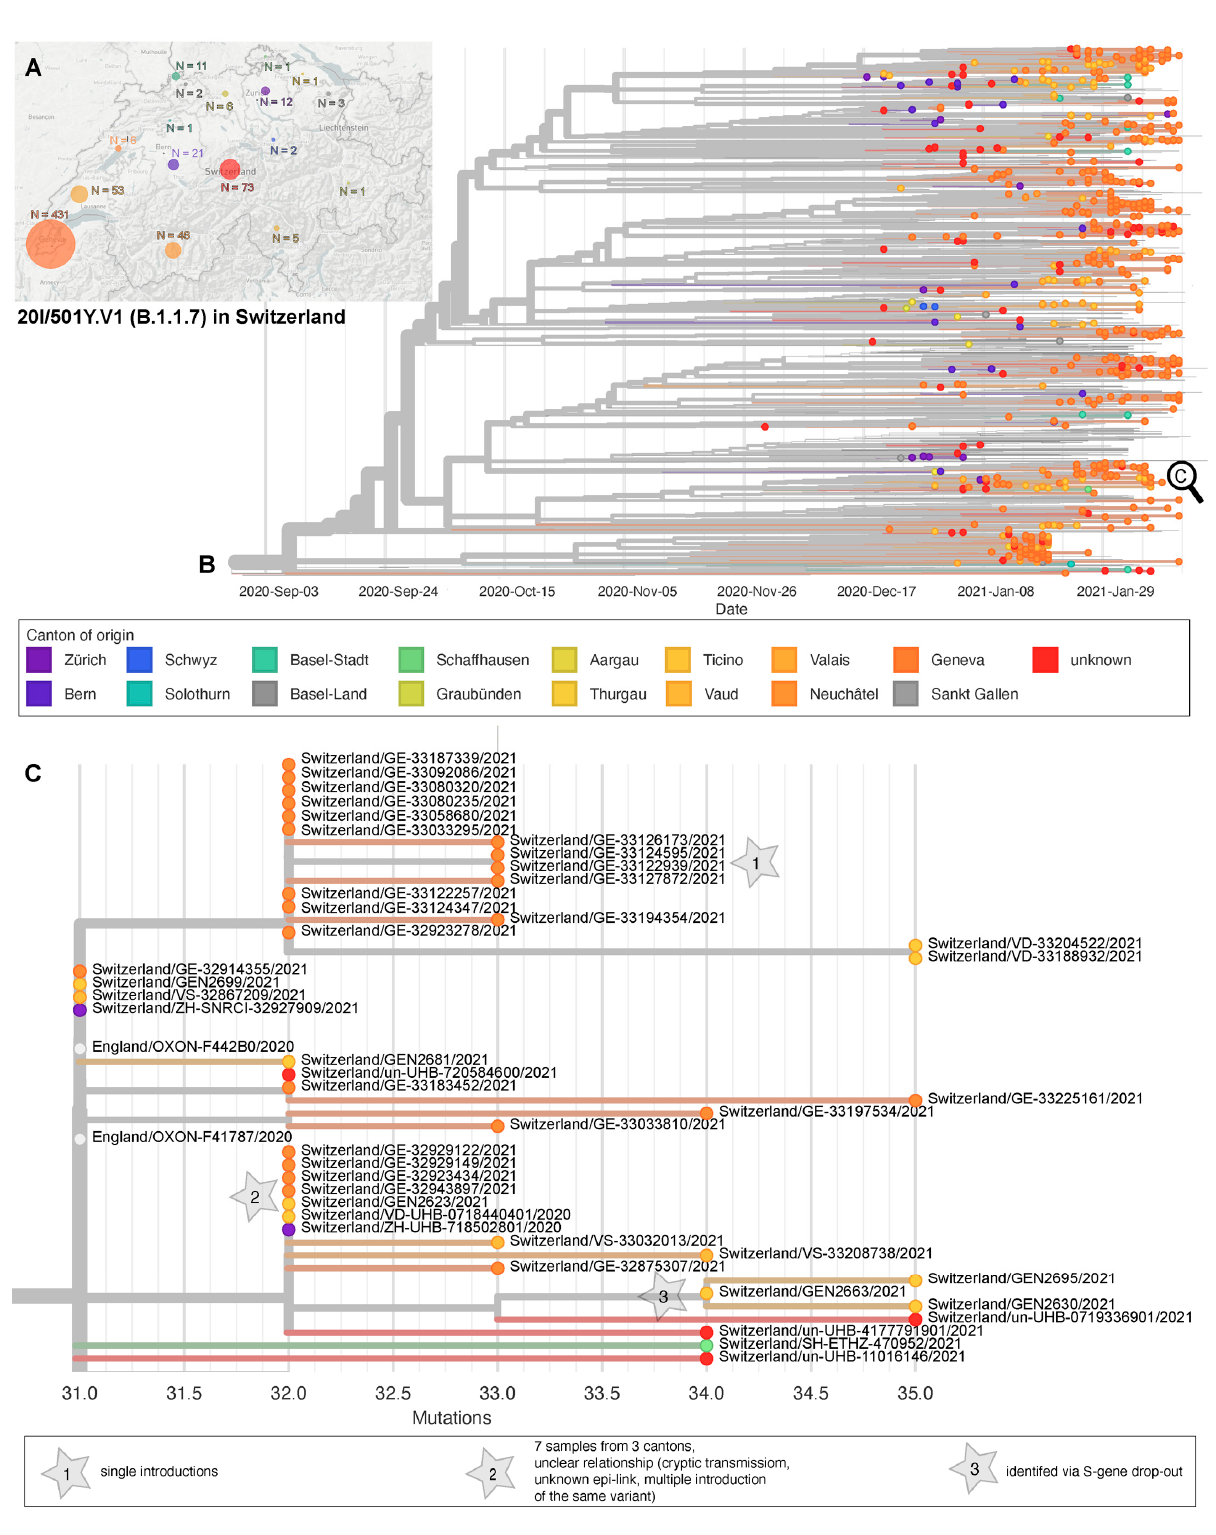
Figure 3. Phylogeny of sequenced B.1.1.7 cases in Switzerland. ( A ) Geographic distribution through Switzerland and ( B ) phylogenetic relationship of 675 genomes dating between 30 November 2020 and 11 February 2021 from the Geneva University Hospitals ( n = 574), University Hospital Lausanne ( n = 44), University Hospital Basel ( n = 70), University of Bern (n = 10), University of Zurich ( n = 14), and ETH Zurich ( n = 20), Center for Laboratory Medicine St. Gallen ( n = 1), Philip Morris International ( n = 6). X-Axis scales to time. ( C ) Zoom into an exemplar, possible cryptic transmissions within a cluster, and single introductions, scale by mutations distance to the reference